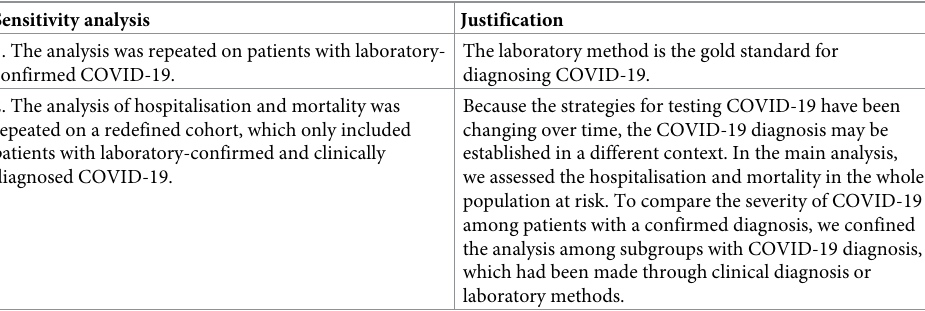
Table 1. Sensitivity